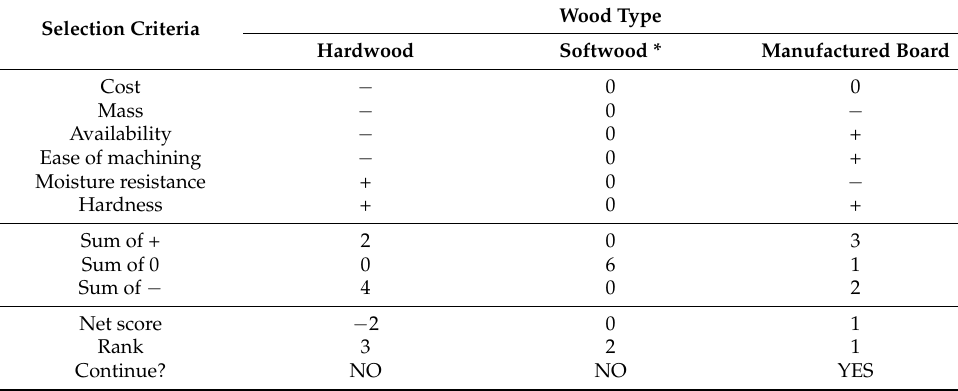
Table 18. Screening of different wood type.